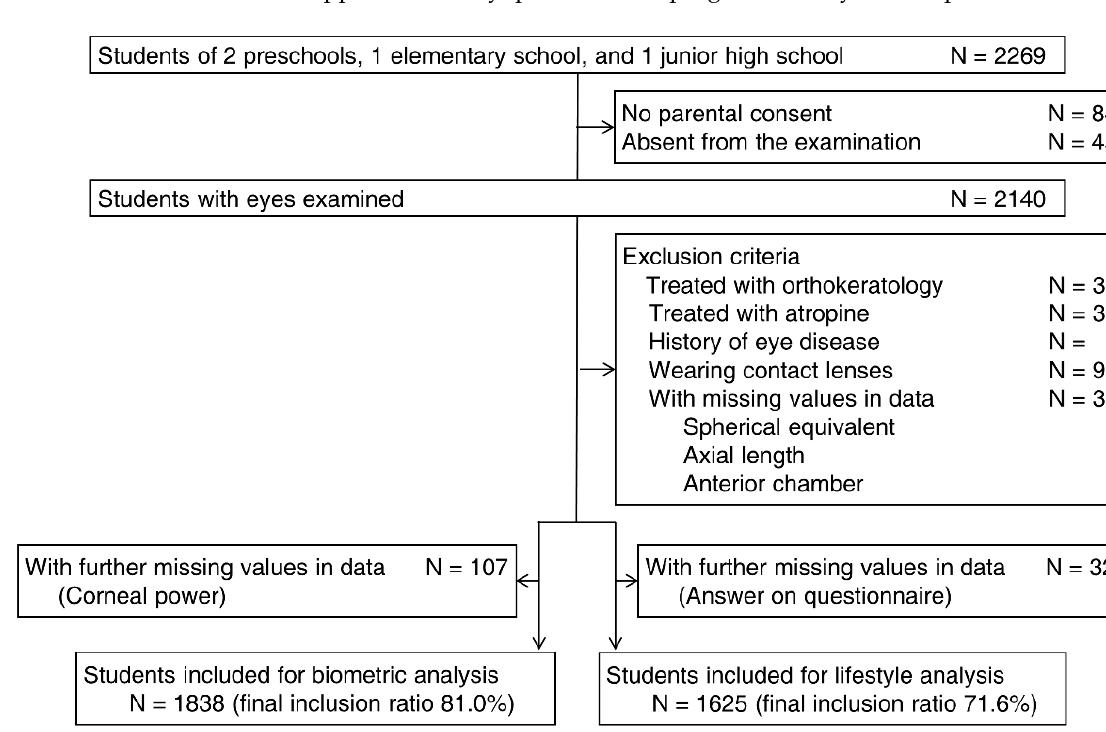
Figure 1. Study flowchart of participant inclusion and exclusion.